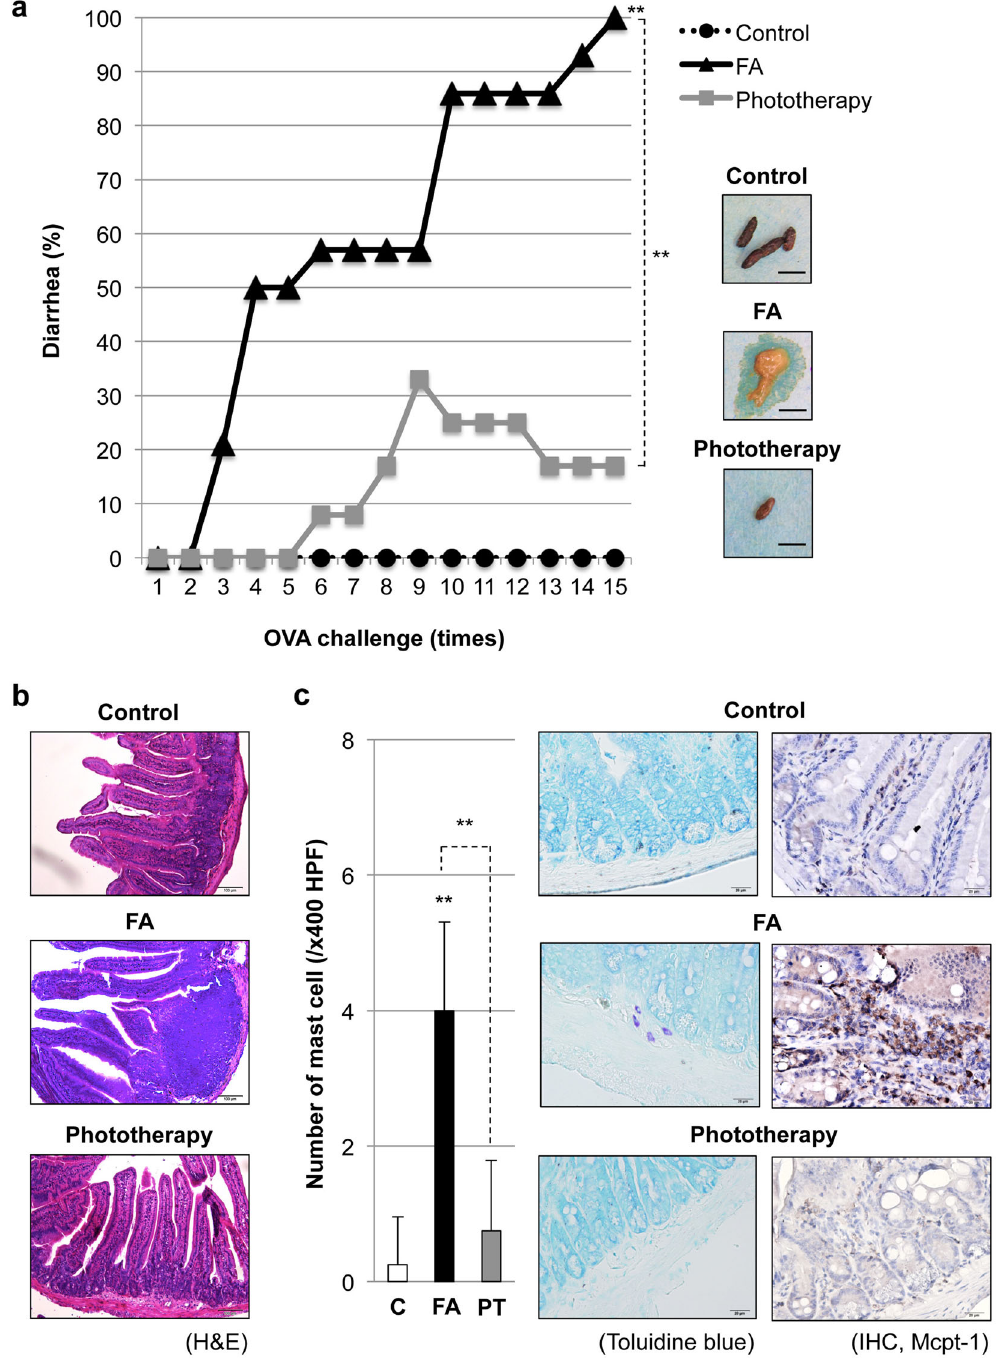
Fig. 1 Impact of phototherapy on the pathogenesis of food allergy (FA). a Establishment of FA mice. Repeated intragastric (i.g.) OVA challenge was performed 15 times in OVA-sensitized BALB/c mice with ( n = 12) or without phototherapy ( n = 14). Naïve mice ( n = 8) without OVA immunization were treated with PBS as a control. Allergic diarrhea was assessed visually by monitoring mice for 30 min after each i.g. exposure. ** P < 0.01 vs. the control group or the indicated pair (Tukey ’ s multiple comparisons test). Enclosed pictures are representative feces after i.g. OVA challenge in the control, FA, and phototherapy groups. Scale bar: 5 mm. b Histological evaluation of the intestines in FA mice. The pictures at ×100 magni fi cation are representative of at least six individuals in each group. H&E hematoxylin and eosin staining. Scale bar: 100 μ m. c Mucosal mast cell activation in FA mice. Left: mast cells were visualized by toluidine blue staining and counted under a microscope at ×400 magni fi cation. Values are presented as the mean ± SD of at least six individuals in each group. C control, FA food allergy, PT phototherapy. ** P < 0.01 vs. the control or phototherapy group (Student ’ s t test). Right: immunohistochemistry (IHC) for mast cell protease 1 (Mcpt-1). The pictures at ×400 magni fi cation are representative of at least six individuals in each group. Scale bar: 20 μ